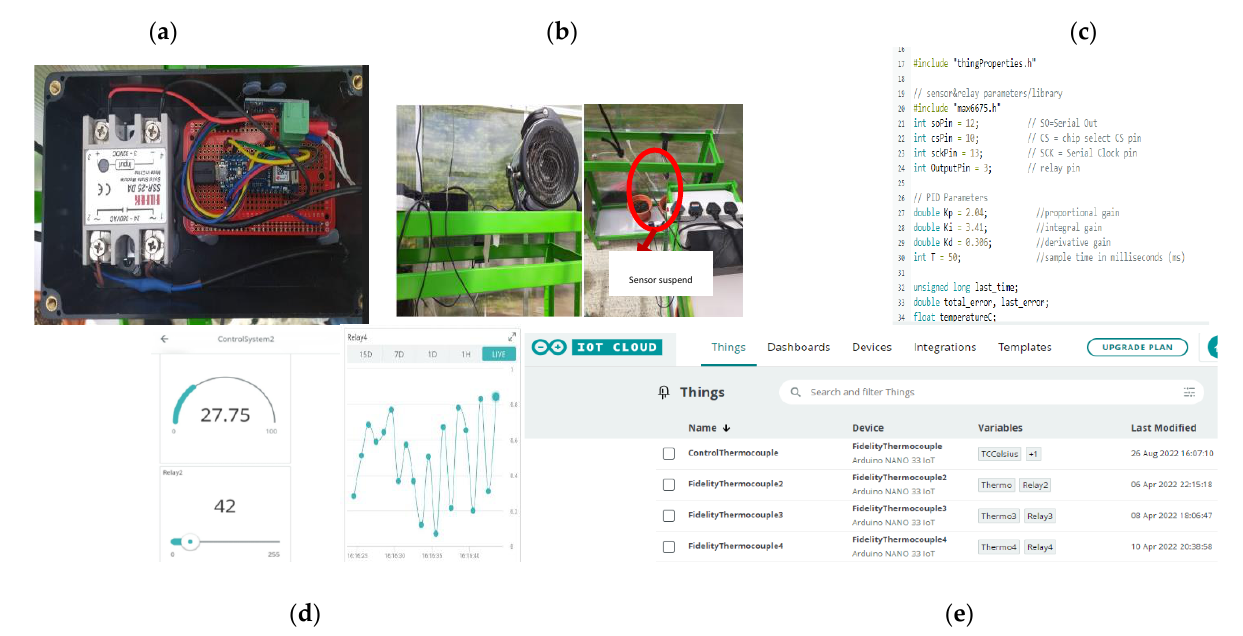
Figure 3. From the left, ( a – e ) is one of the IoT control system content; the interior view of the greenhouse showing the 2 KW, a suspended sensor in the air and planting pots; Arduino IoT cloud customisable software; user interface mobile app; and web-based app.